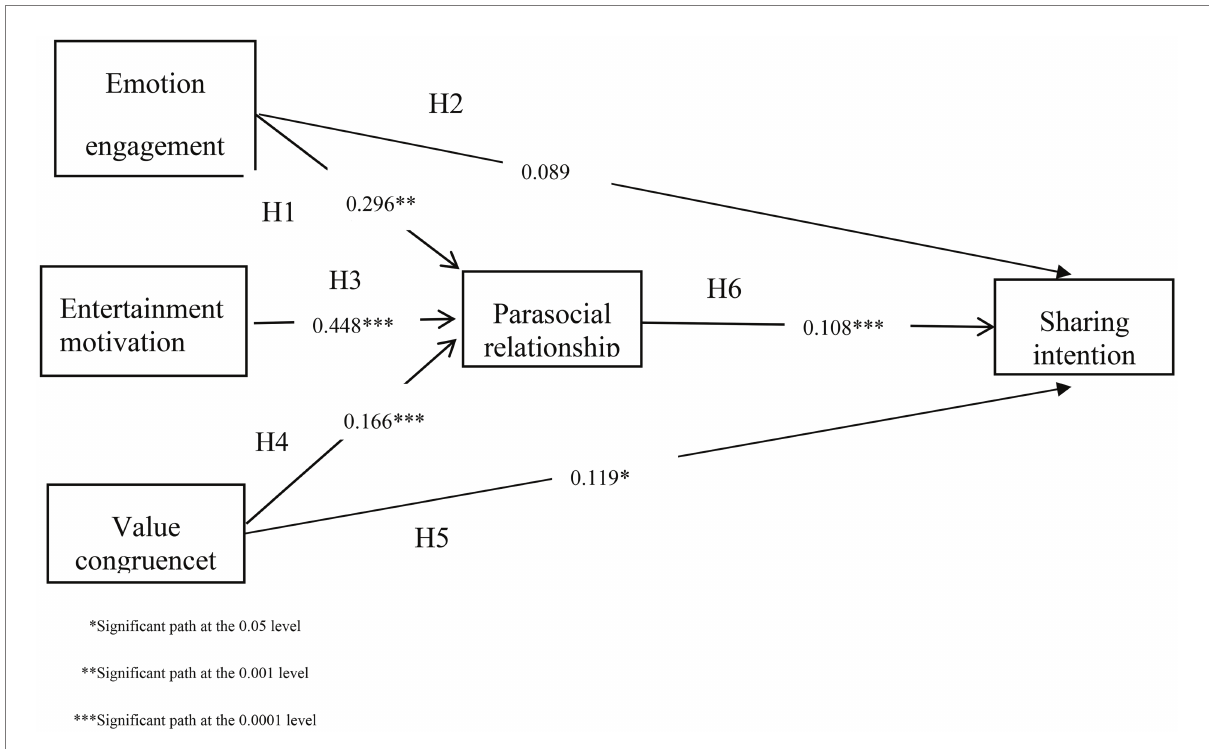
FIGURE 2 Final structural model with standardized path coefficients.